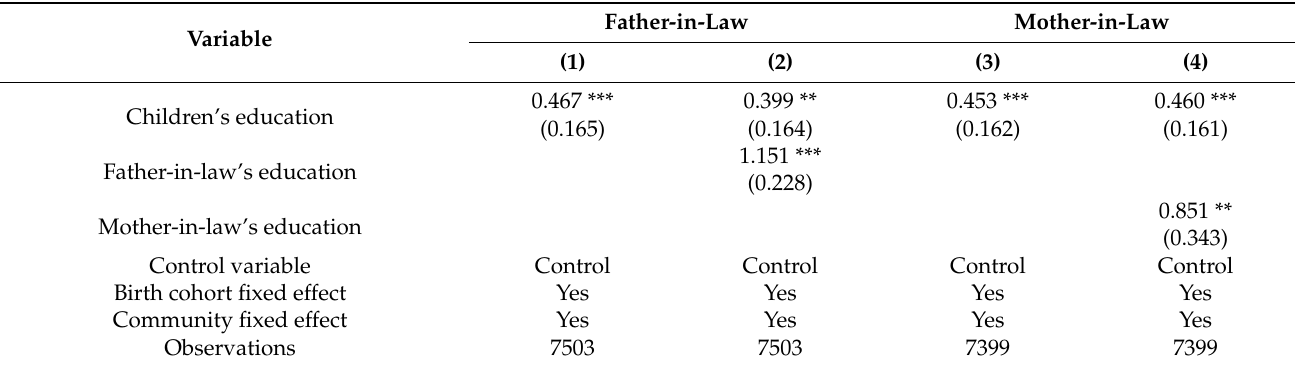
Table 8. Results for the analysis of parents-in-law’s